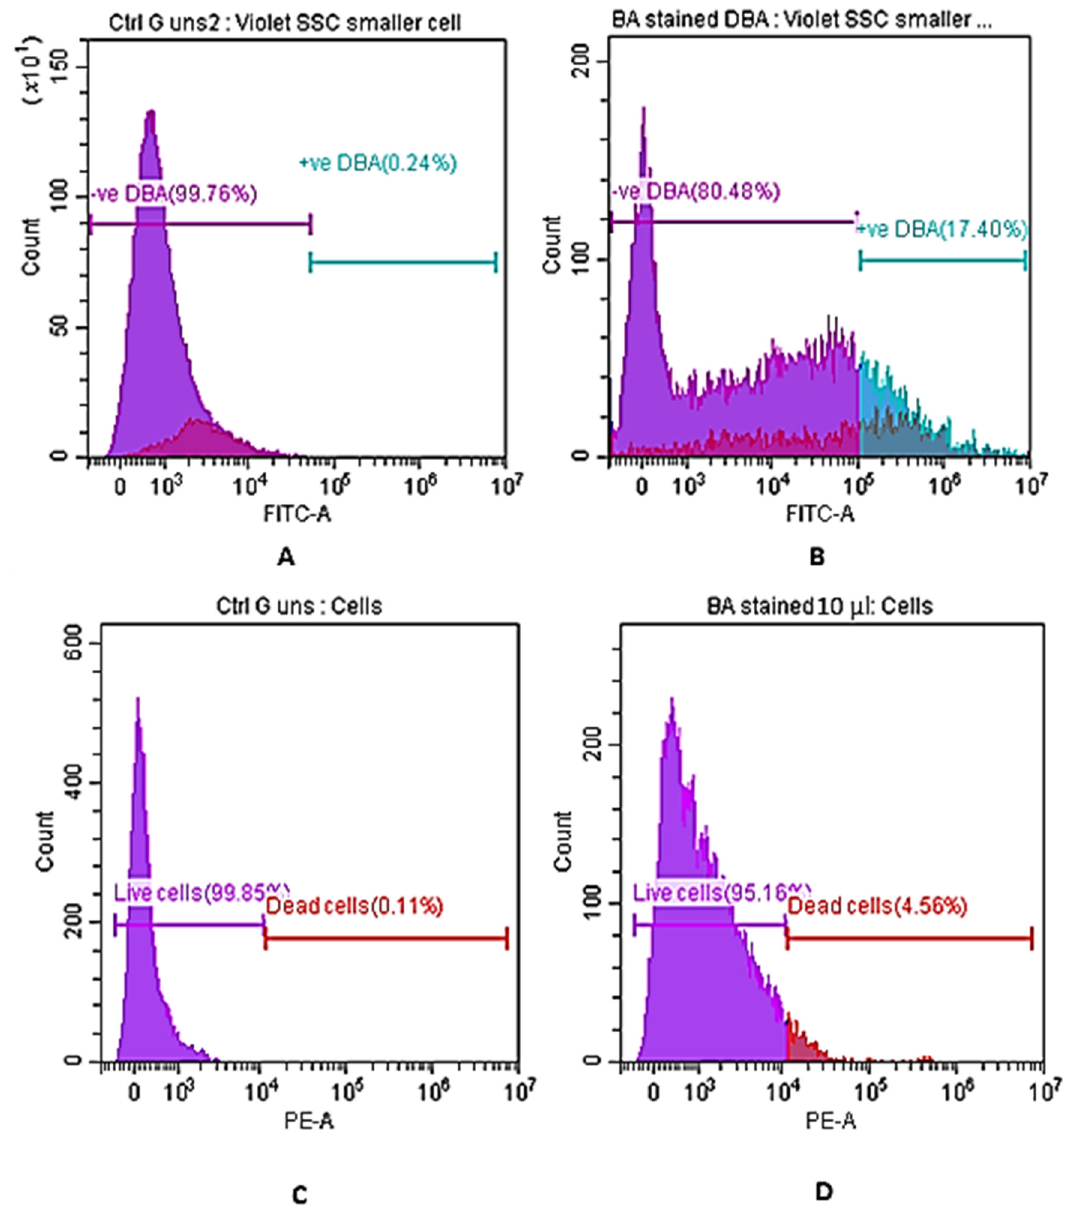
Figure 3. The percentage of membrane stained with Dibac4(3) for detection of membrane depolarization of ( A ) untreated, and ( B ) benzoic acid-treated G. boninense cell. The percentage of nucleus stained with propidium iodide for detection of living and dead cells of ( C ) untreated and ( D ) benzoic acid-treated G. boninense cell based on flow cytometer analyses.